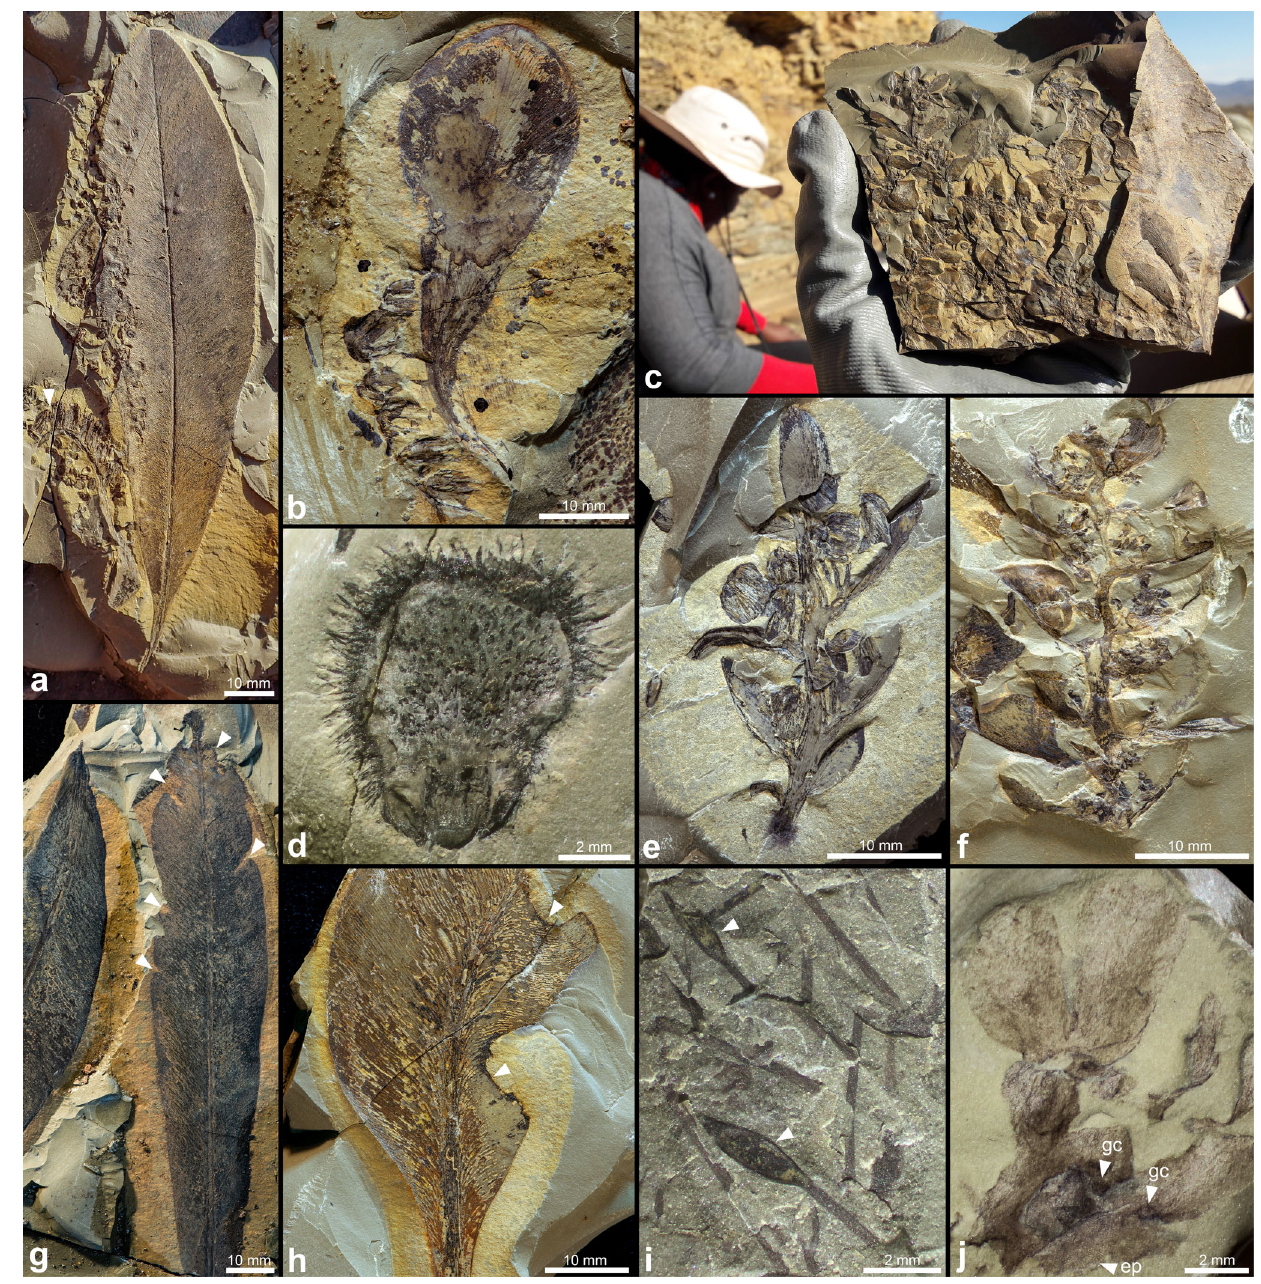
Fig. 4 Key plant fossil discoveries from the Onder Karoo locality. a Glossopteris leaf with abundant platyspermic seeds to the left. Arrow indicates adjacent Lidgettonia sp. 1 fructi fi cation, the likely source of the seeds. b Lidgettonia sp. 1: large scale leaf with at least fi ve pairs of cupules attached. c Slab showing mixed mat of male and female cones of the Glossopteris plant. d New dictyopteridean, seed-bearing glossopterid fructi fi cation Ottokaria . e Female cone of Glossopteris plant: multiple Lidgettonia sp. 2 fertiligers attached to a shoot. f Male cone of Glossopteris plant: multiple Eretmonia sp. polleniferous scales attached to a shoot. g Glossopteris leaves, arrows indicate sites of margin-feeding by insects. h Glossopteris leaf with arrows indicating large excisions caused by insect feeding, note pronounced staining of plant reaction tissue. i Probable moss sporophytes, arrows indicate moss capsules. j Thallose liverwort with dichotomous branching, notched termini, hydroids, typical epidermal patterning (ep, arrow) and possible gemma cups (gc,